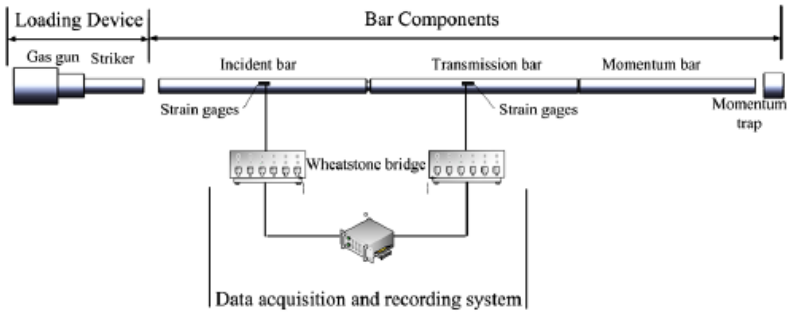
Figure 1. Schematic diagram of the device. The experimental temperatures were set at 298.15, 323.15, 373.15 and 473.15 K, and the strain rate varied from 6 × 10 − 3 S − 1 to 3 × 10 3 S − 1 , in which the quasi-static